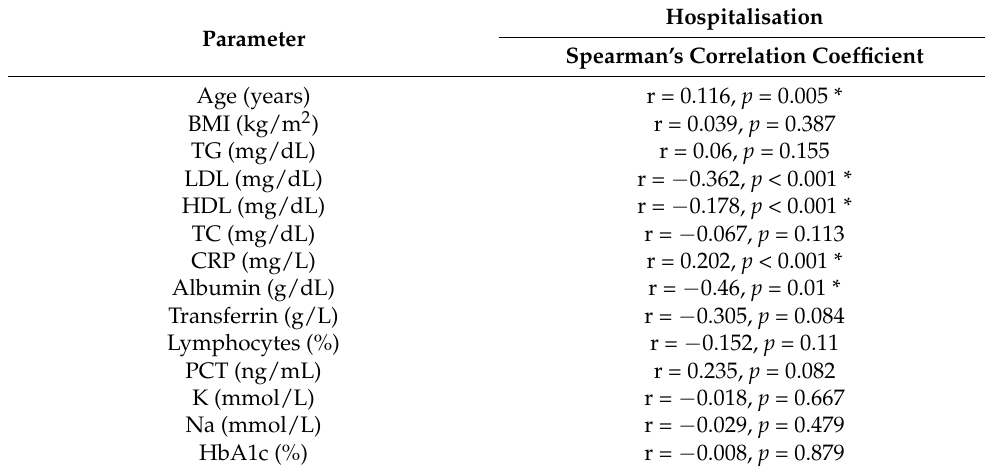
Table 6. Length of hospital stay (quantitative variables): univariate analysis.